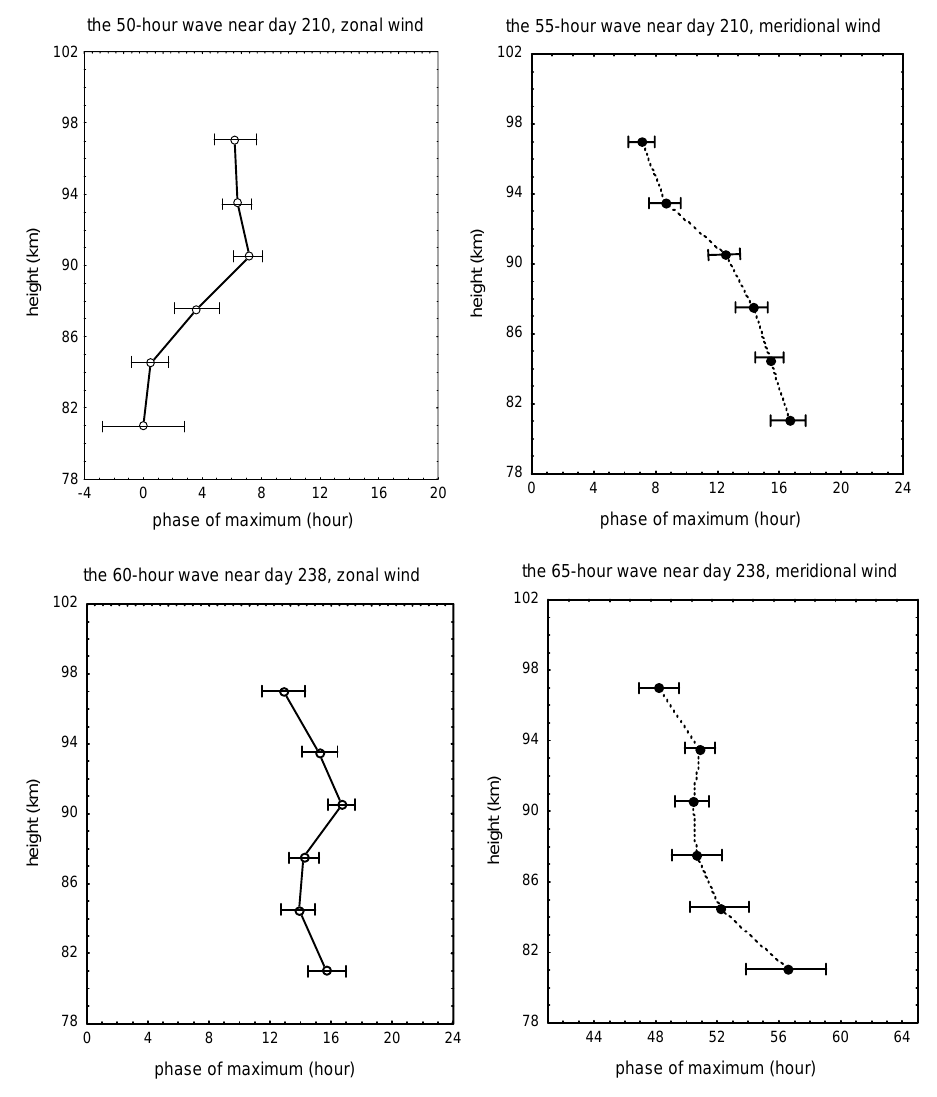
Fig. 5. Phase profiles for two main bursts of the QTDW activity at Esrange.